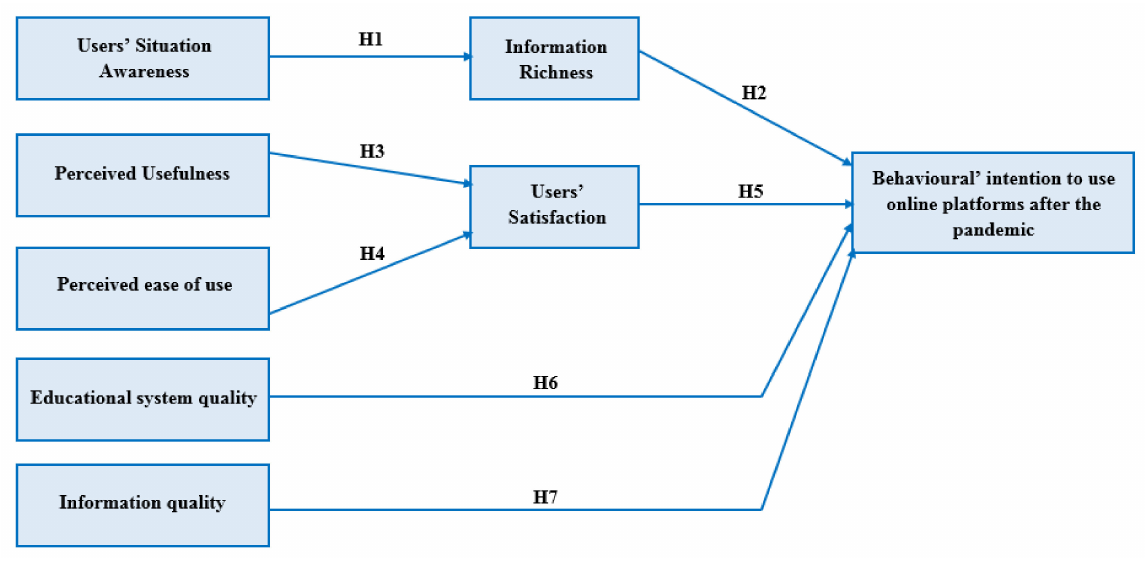
Figure 1. Research